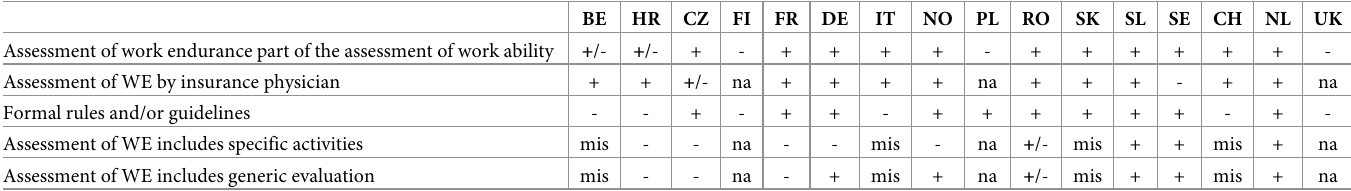
Table 1. The assessment of work endurance in European countries (n =